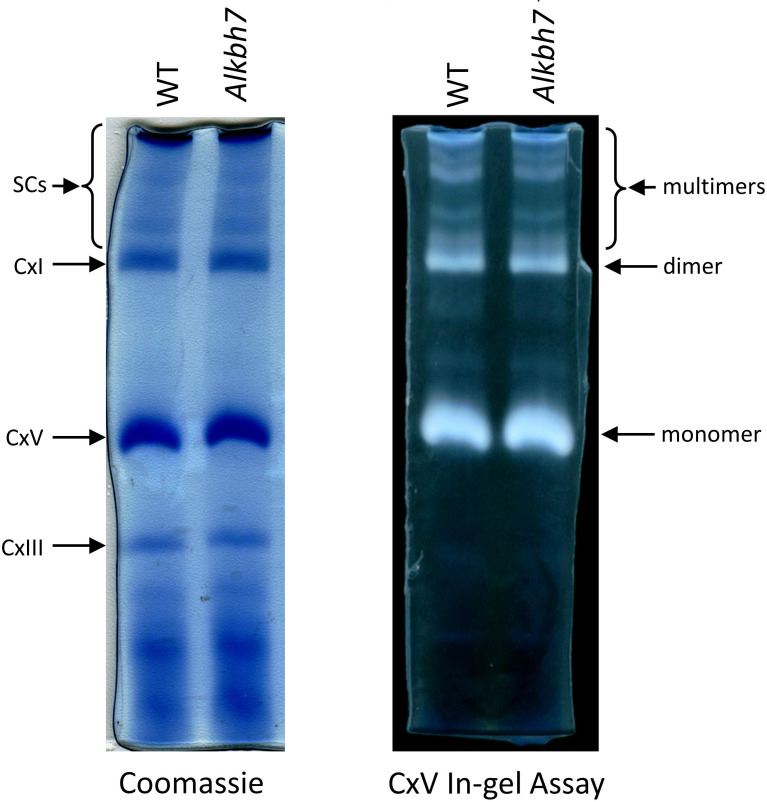
Blue-native analysis of mitochondrial respiratory supercomplexes.Heart mitochondria from WT or Alkbh7-/- mice were separated by blue-native PAGE as per the methods. (A) Original gel showing positions of respiratory complexes I, V and III, and supercomplexes (SCs) at the top. Note, gel was not stained post-hoc with Coomassie blue, but gel conditions contain the dye, such that gels appear with blue bands immediately upon electrophoresis. (B) Complex V in-gel assay. White bands show lead precipitate resulting from ATPase activity of complex V. Monomeric, dimeric, and multimeric forms of complex V are indicated. Gels are representative of at least three independent experiments.